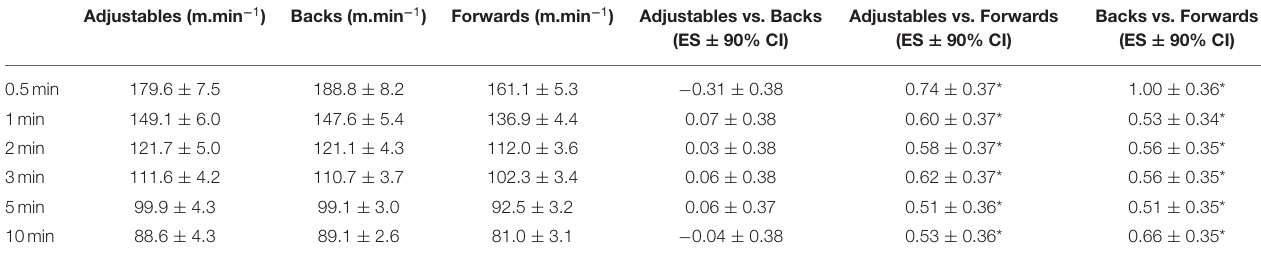
TABLE 1 | Peak running